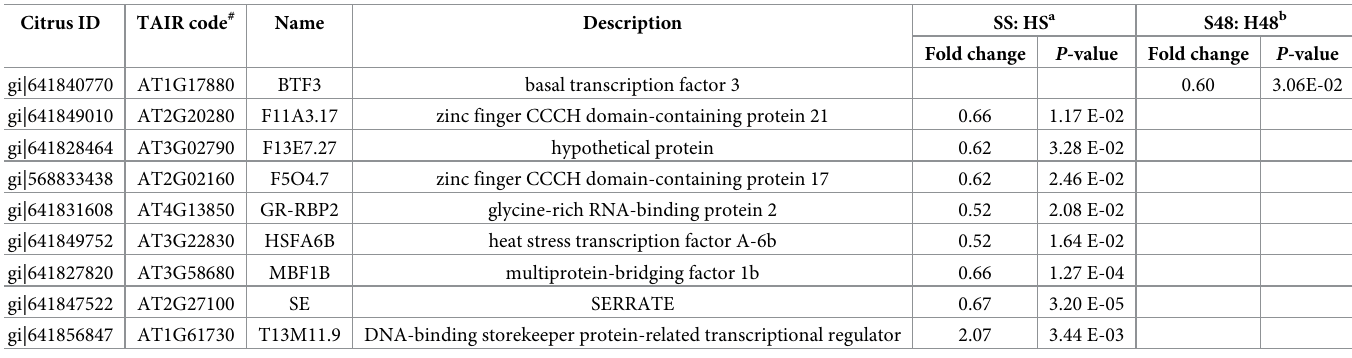
Table 1. The differentially-expressed transcription factors in Huanglongbing (HLB)-symptomatic fruit, from sensitive and tolerant rootstocks respectively. Citrus ID TAIR code